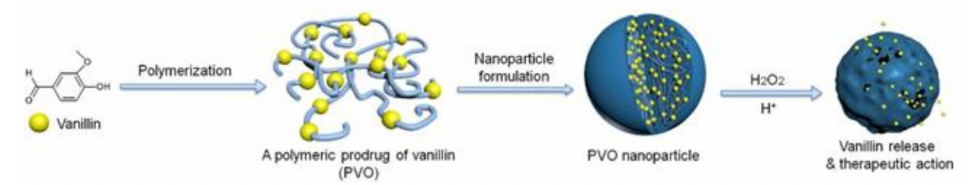
Figure 5. PVO Nanoparticles preparation and degradation [41] Reprinted with